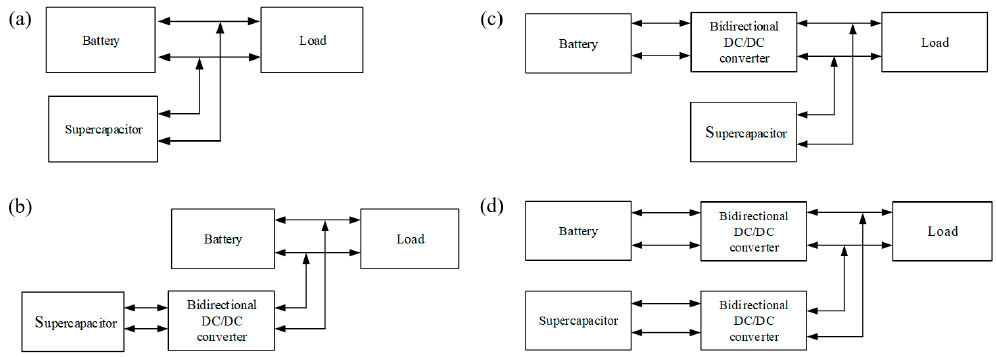
Figure 1. ( a ) Direct parallel structure; ( b ) Structure of SC control; ( c ) Structure of battery control; ( d ) Structure of two power supply control.